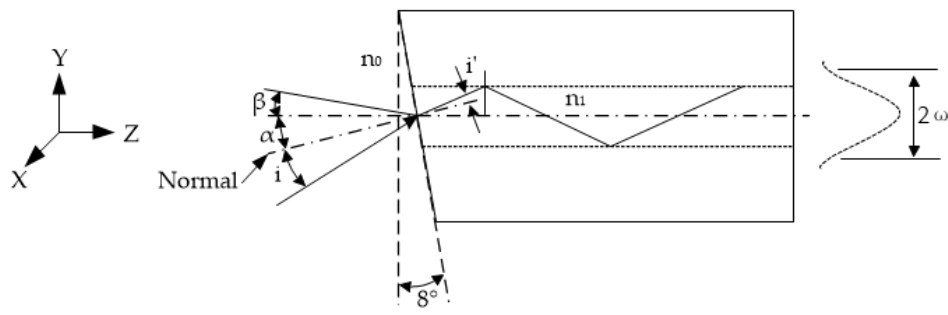
Figure 5. Schematic diagram of the end − face with 8° of fiber.